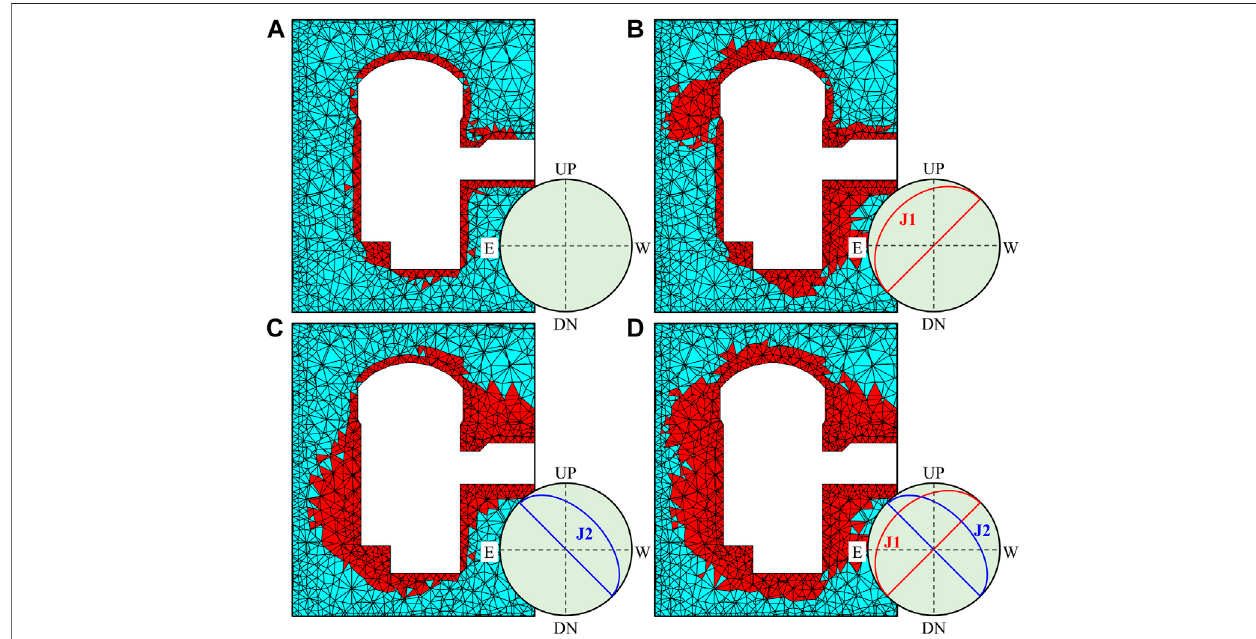
FIGURE 9 | Comparison of the plastic zones calculated by the (A) M – C model, (B,C) U-J model, and (D) enhanced model.